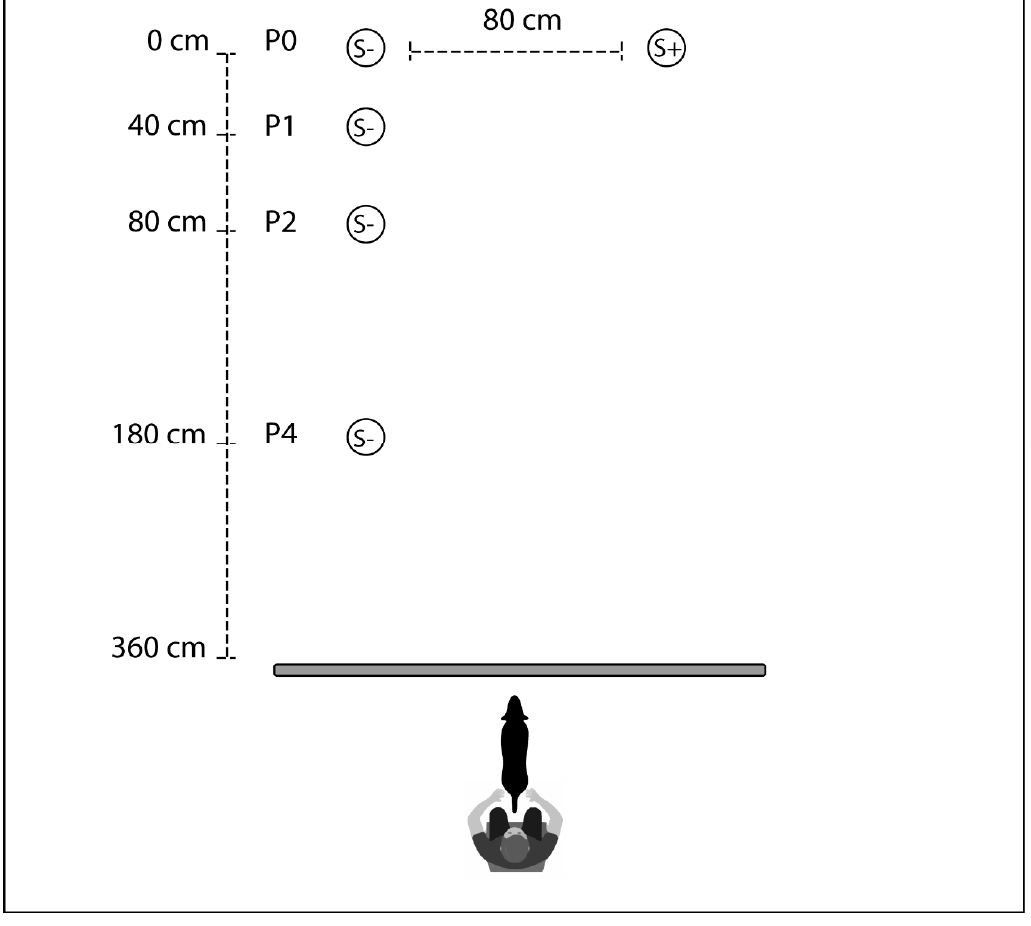
Figure 1. Experimental setting. Representation of the experimental setting, illustrating the owner’s and dog’s position behind the curtain (large horizontal grey bar) at the start of presentations, and the position of the bowls containing the larger (S+) and the smaller amount of food (S − ) during training (P0) and test trials (P0 for S+, P0 to P4 for S − ).